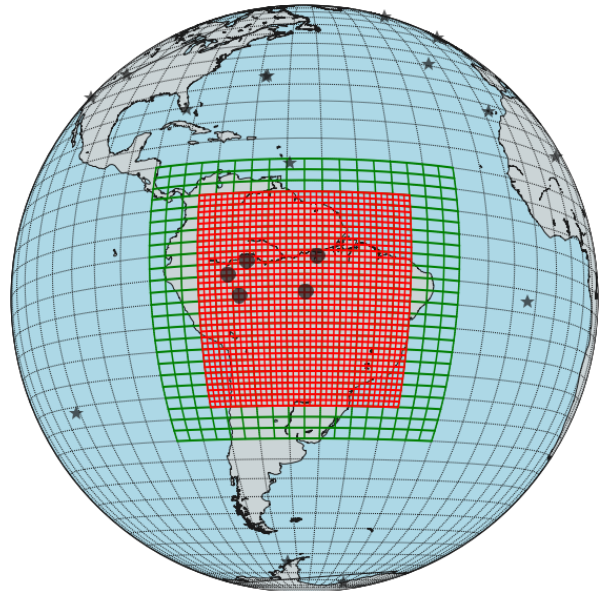
Figure 1. A map of the South American zoom regions used in the TM5 simulations. The green and red grids indicate the 3 ◦ × 2 ◦ and 1 ◦ × 1 ◦ (longitude × latitude) zoom regions respectively. Over both zoom regions, satellite data are assimilated. Filled stars indicate the NOAA Global Greenhouse Gas Reference Network surface sites, from which surface observations are assimilated to constrain global CO emissions, and, by extent, the boundary conditions of the zoom domains. Filled circles indicate sites where discrete whole-air sam- ples were collected by aircraft at various altitudes. The CO data cal- ibrated on whole-air samples are used for independent evaluation of the